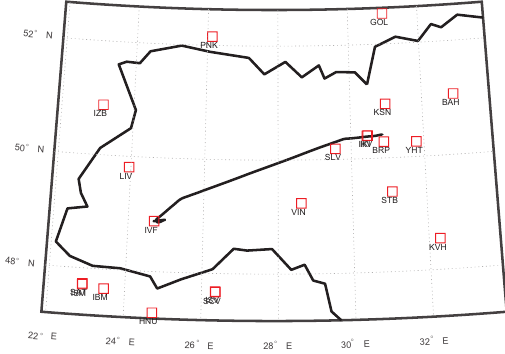
Figure 7. Flight track of “AUI79” in geodesic coordinate system with all available DMEs